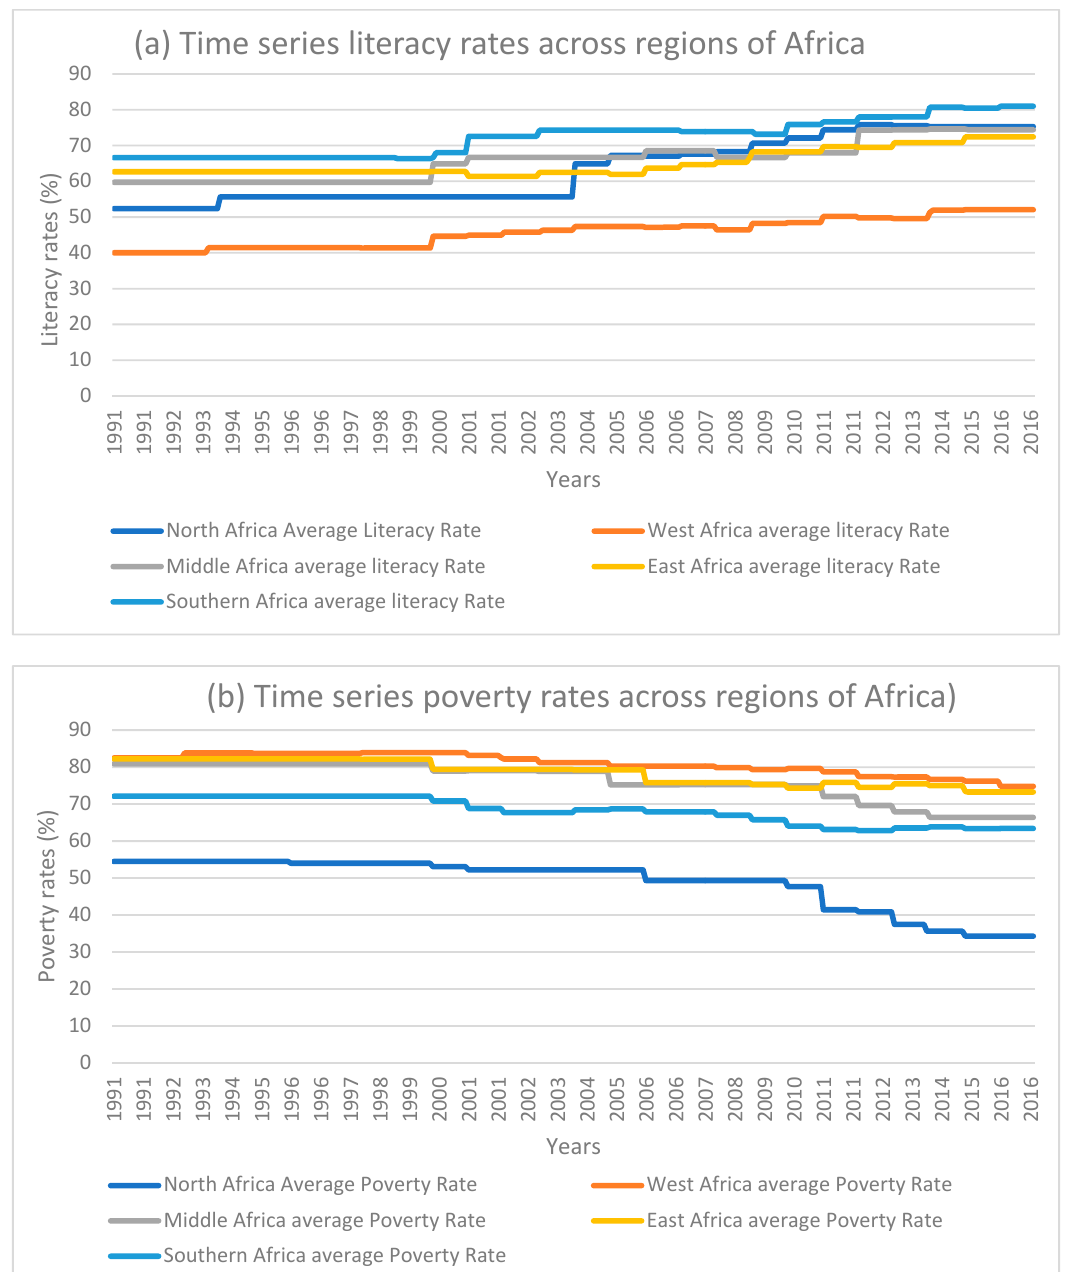
Figure 3. Recent trends in ( a ) literacy and ( b ) poverty rates across Africa. Source: author’s conceptualization.